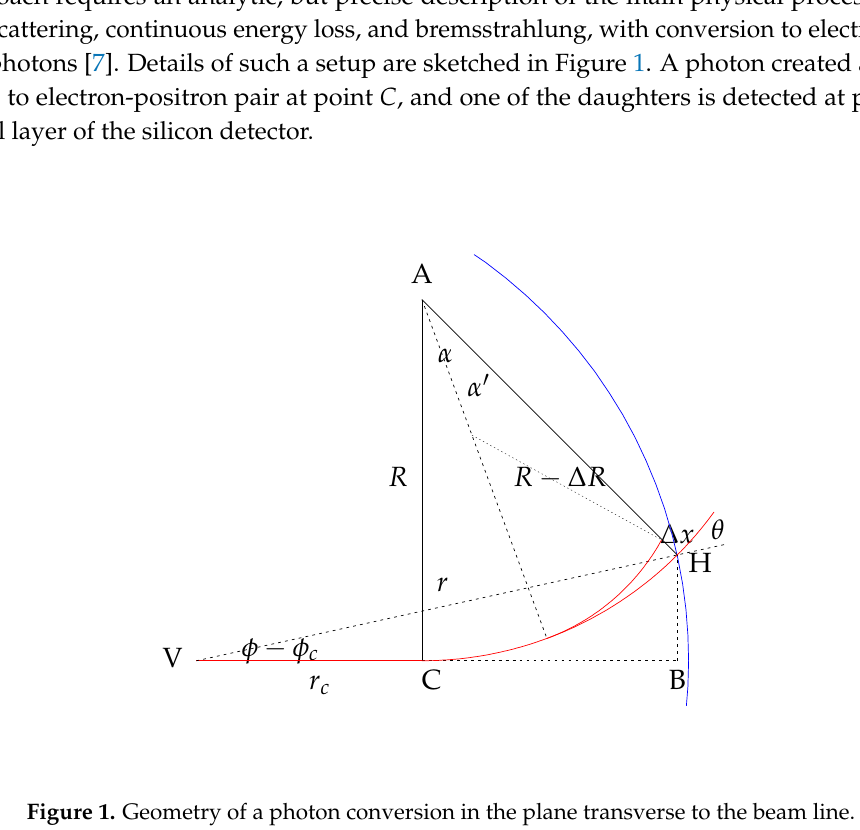
Figure 1. Geometry of a photon conversion in the plane transverse to the beam